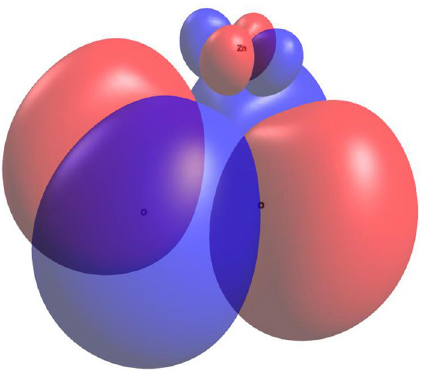
Figure 7. The highest occupied molecular orbital of Zn 2 + - O2 . − ]. Imaged rendered using Avogadro (https:// avoga dro.